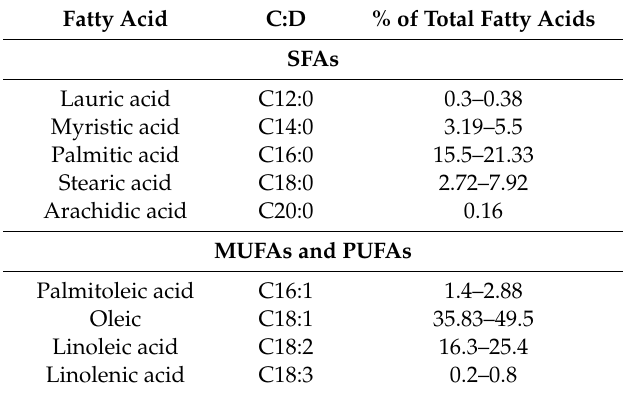
Table 4. Main fatty acid composition of